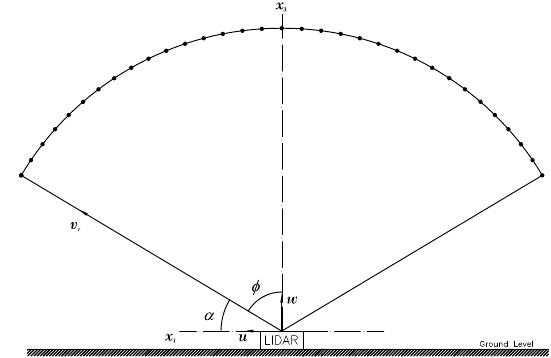
Fig. 3. Schematic of the lidar operating in a RHI scanning